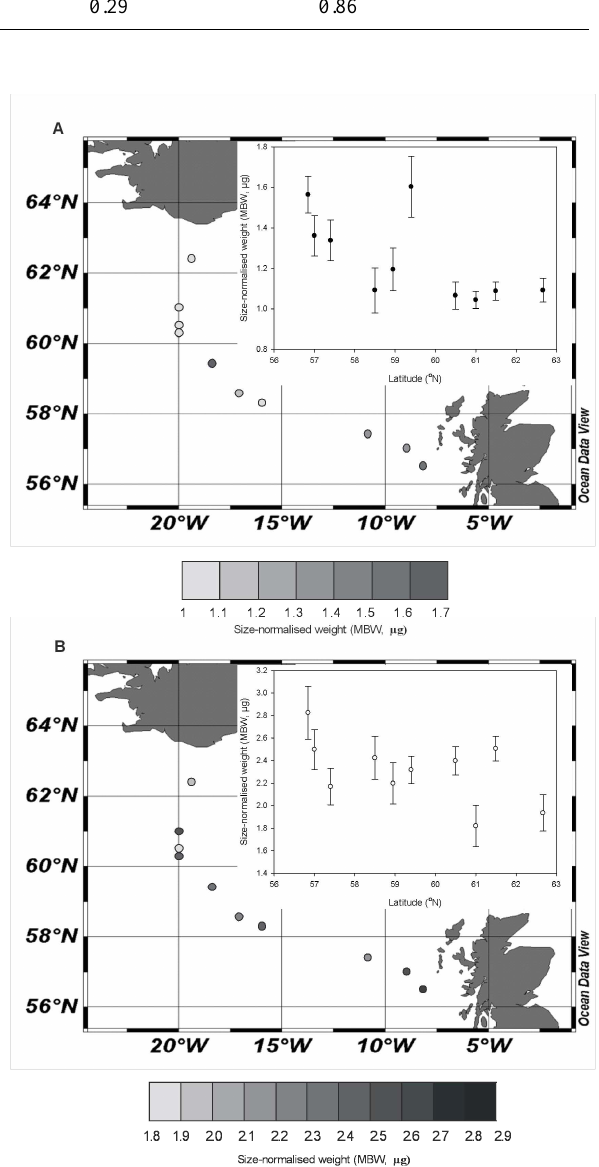
Fig. 5. The spatial distribution of G. bulloides SNWs in the North Atlantic, between Iceland and Scotland, for 150–200µm (A) and 200–250µm (B) size fractions. Inserted panels show SNW varia- tions with